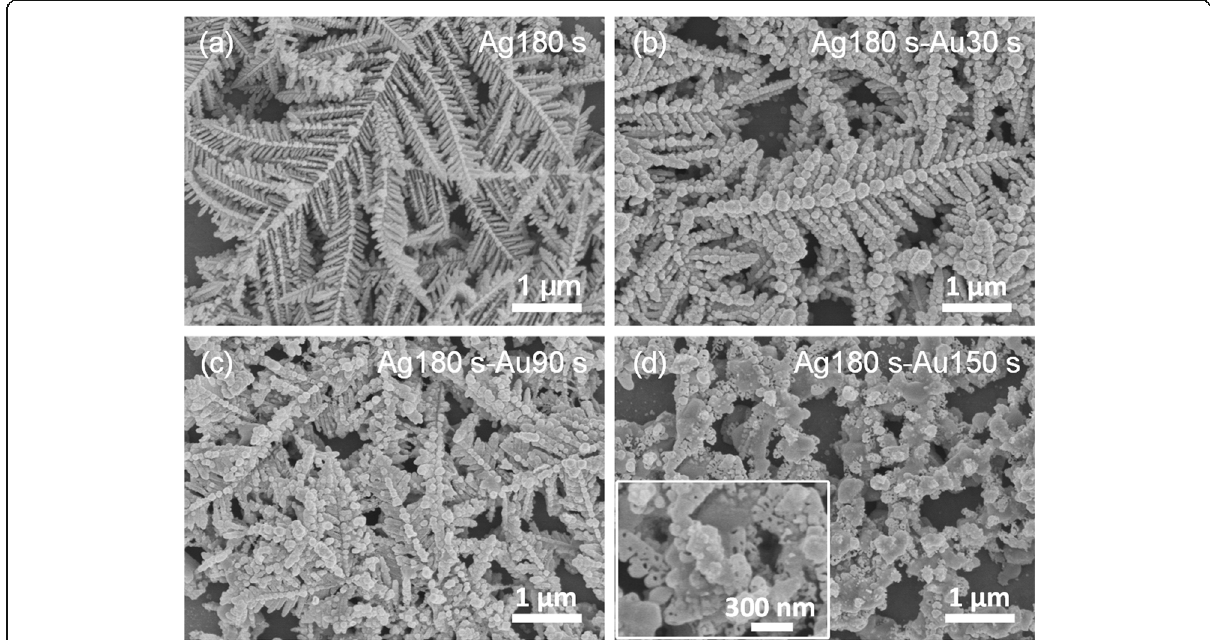
Fig. 1 SEM images of the a dendritic Ag nanostructures and b – d dendritic Au/Ag bimetallic nanostructures prepared after different replacement reaction time: 30, 90, and 150 s, respectively. For simplicity, these samples were designated as bimetallic nanostructure (Ag180s-Au0s), (Ag180s- Au30s), (Ag180s-Au90s), and (Ag180s-Au150s), respectively. Inset is the corresponding high-magnification SEM